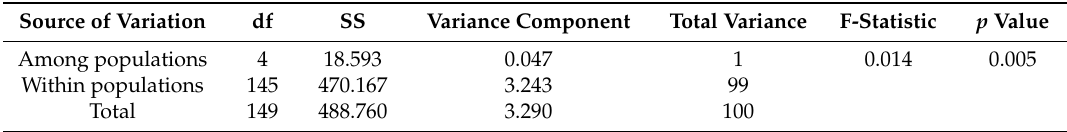
Table 6. Analysis of molecular variance (AMOVA) for 150 individuals in five populations of Norway spruce.